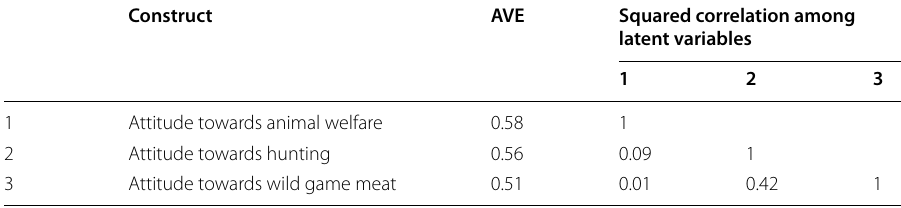
Table 4 Convergent and discriminant validity